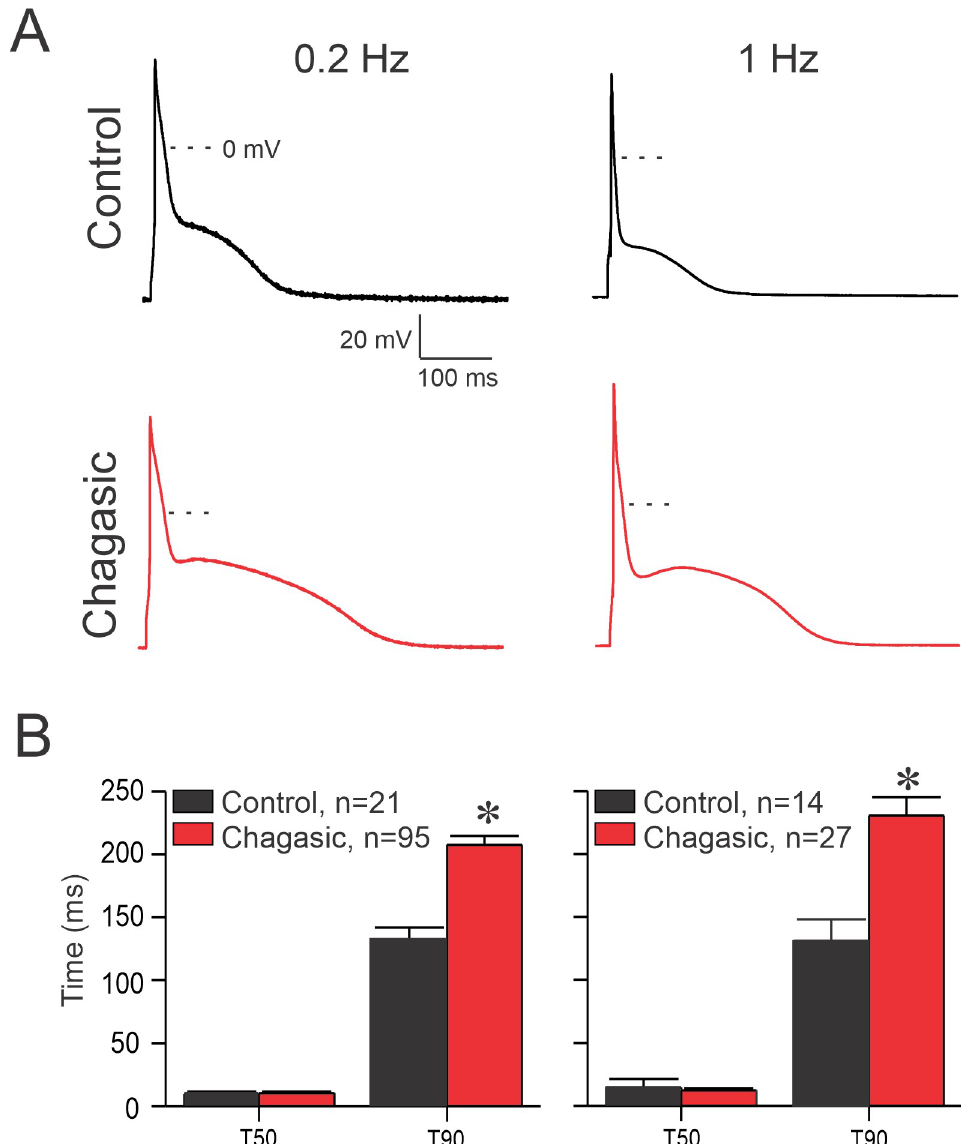
Fig 1. Prolonged action potential (AP) duration in chagasic cardiomyocytes. (A) Representative AP recorded from control (black traces) and infected (red traces) isolated cardiomyocytes paced at 0.2 Hz and 1 Hz. (B) Time required to 50% (T 50 ) and 90% (T 90 ) of full AP repolarization at 0.2 Hz and 1 Hz. Data were analyzed using Two-way ANOVA. n represents the number of cells. � p < 0.05.